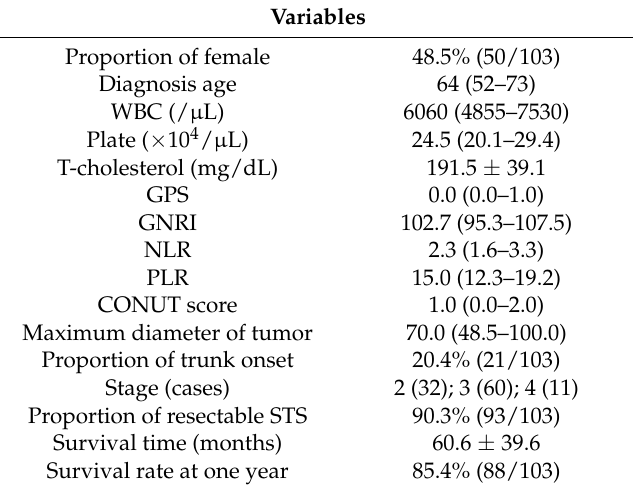
Table 1. Demographic data of soft tissue sarcoma (STS) patients.